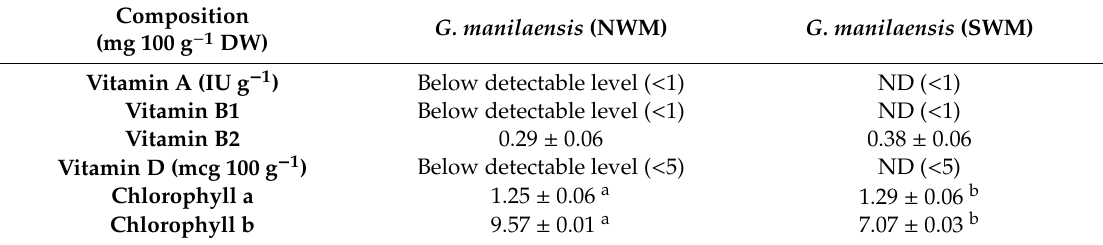
Table 5. Variation in Vitamin Composition (mg g − 1 DW), Chlorophyll A and B Content ( µ g g − 1 DW) of G. manilaensis